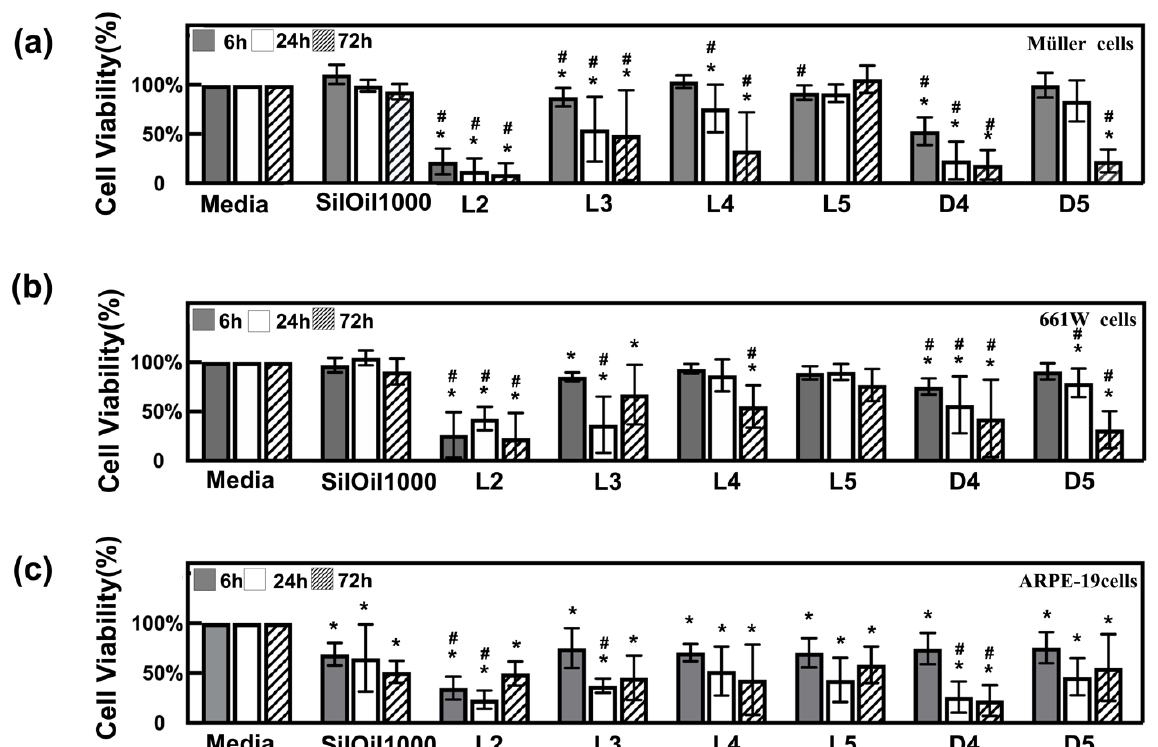
Figure 4. Cytotoxicity of emulsified LMWCs. Cell viability of ( a ) Müller cells (rMC-1); ( b ) photoreceptor cells (661W); and ( c ) retinal pigment epithelial cells (ARPE-19) after incubation with various types of emulsions at different time points. n = 6, * p < 0.05, vs. media; # p < 0.05, vs. SilOil 1000 (one-way ANOVA followed by Bonferroni test). Scale bar = 50 µ m. The results in ( a – c ) are representative of those from 3 independent experiments with 2 replicates each.